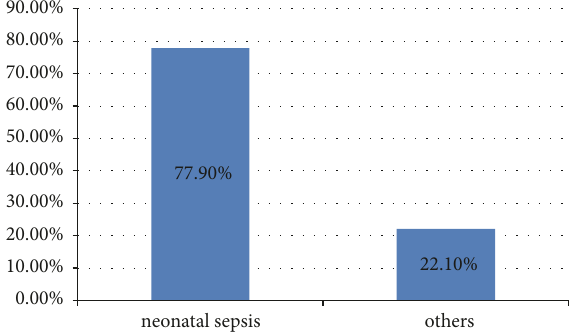
Figure 2: Diagnosis of neonatal sepsis and others cases, in Shashemene referral hospital and Melkaoda General